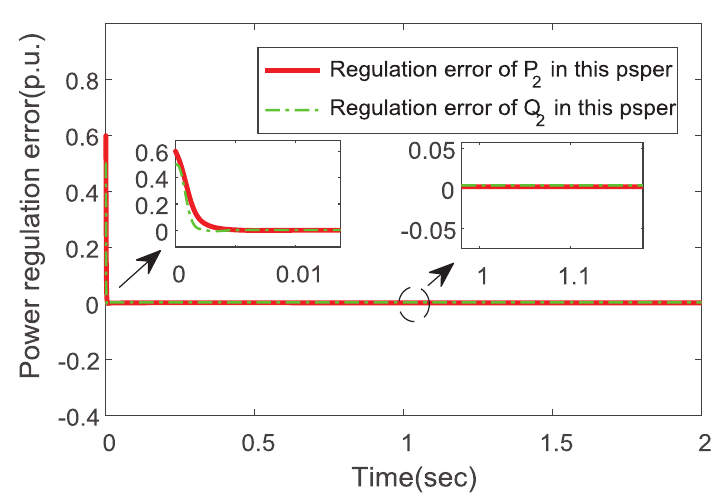
Figure 6. Tracking error of P 2 and Q 2 in this